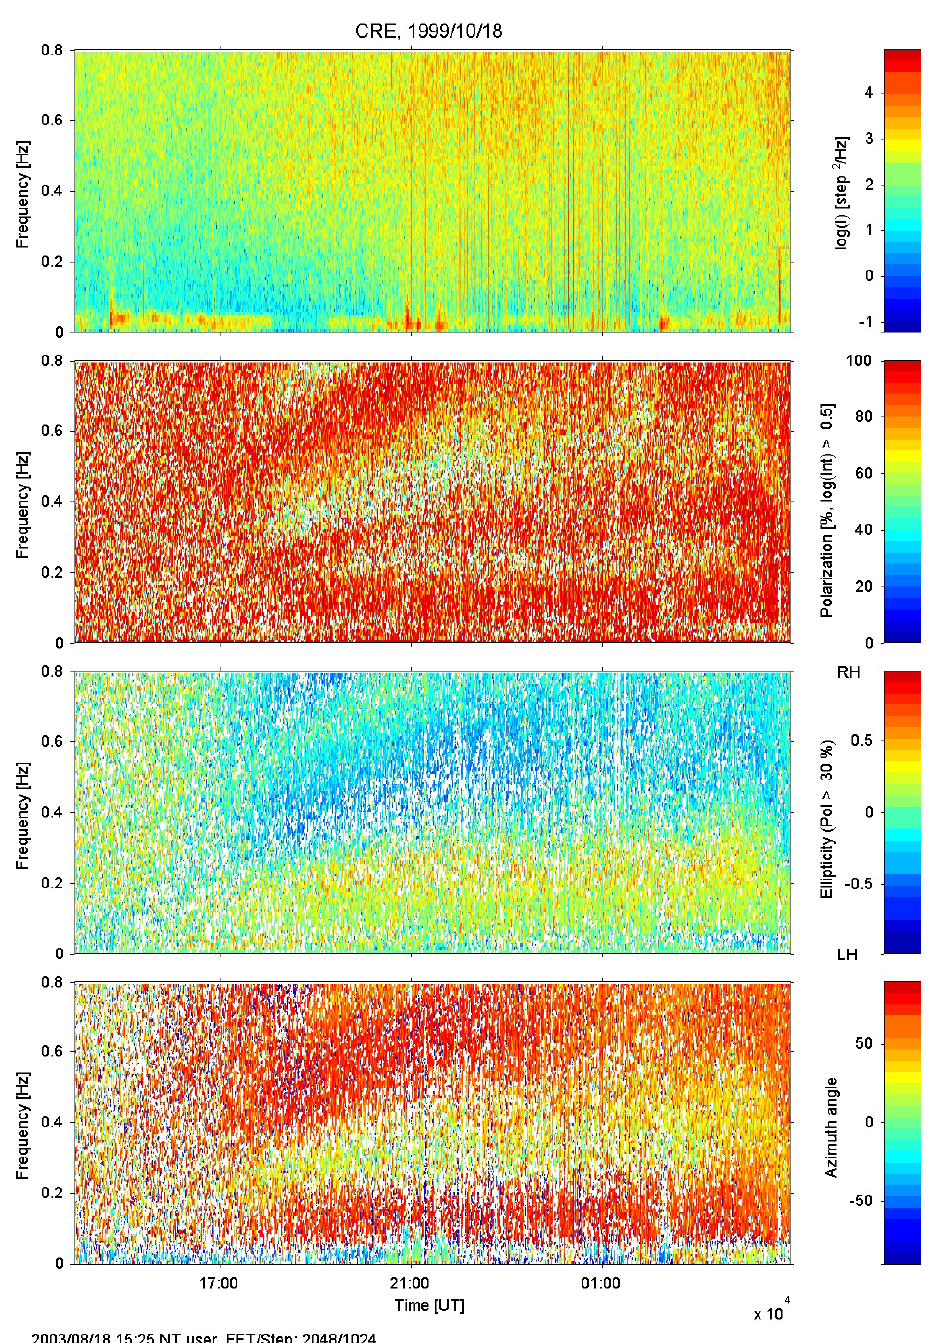
Fig. 7. The same as Fig. 3 but for the low frequency part alone, and with a time axis extending to the morning of the following day; compare also with Fig.